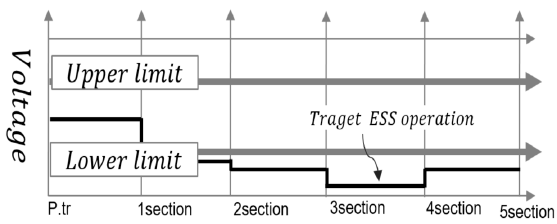
Figure 10. Case of voltage being violated in multiple sections.